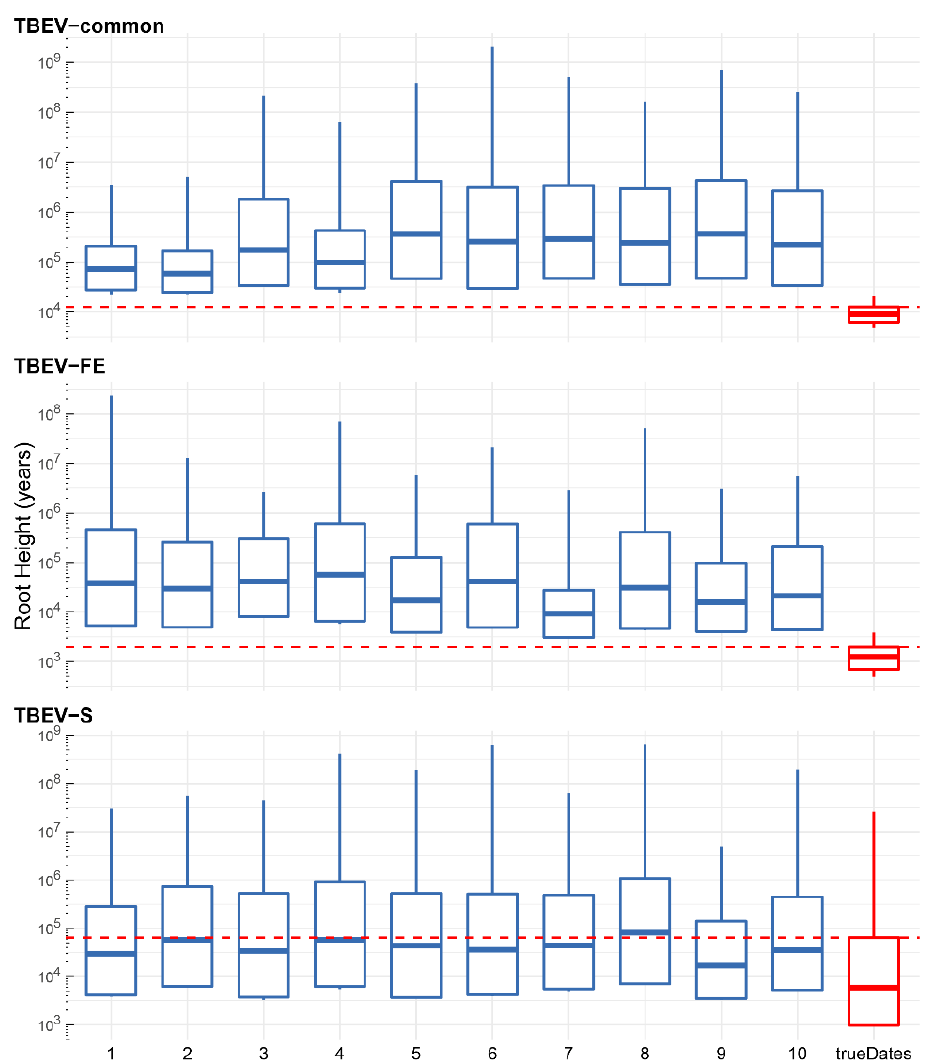
Figure 2. Permutation test results for the common clade of tick-borne encephalitis virus (TBEV-common), Far-Eastern (-FE) and Siberian (-S) subtypes of TBEV. Log Y-axes represent root height values in years before the most recent sample (2 June 2021). Blue boxplots indicate 10 pseudo-replicas with permuted dates in each analysis, and red boxplots represent MCMC runs with true collection dates for each sample/sequence. Red dashed lines show the upper limit of 95% highest posterior density (HPD) intervals of analyses with true dates.